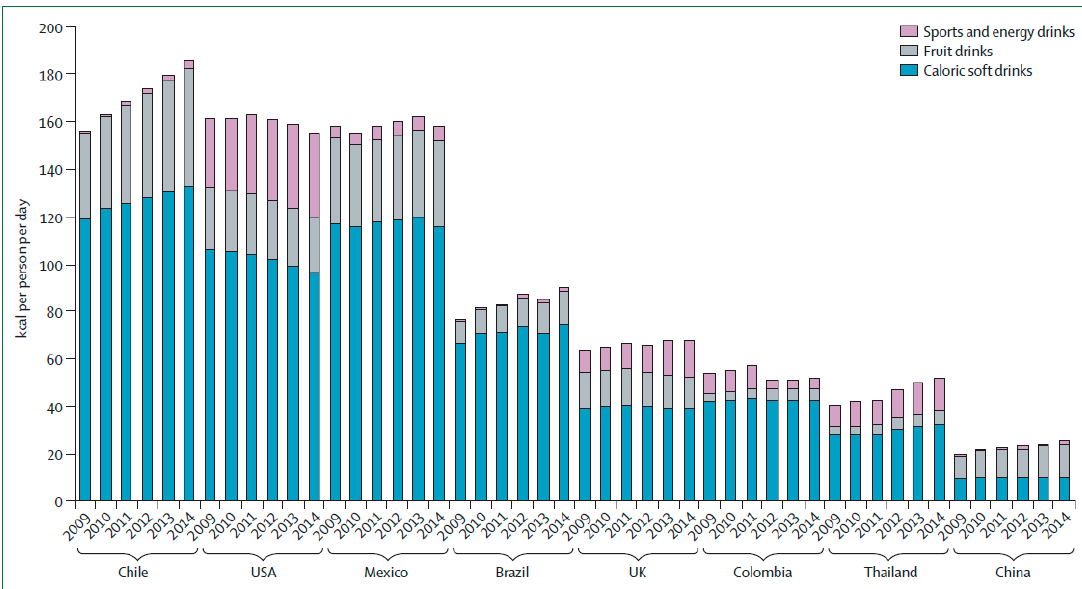
Figure 1. Sales of sugar-sweetened beverages (SSBs) in kcal per person per day by beverage type in 2009–2014 in selected countries. Data from Euromonitor Passport International, which were obtained from nutrition fact panels and websites of sugar-sweetened beverage companies; kcal = kilocalories [18].